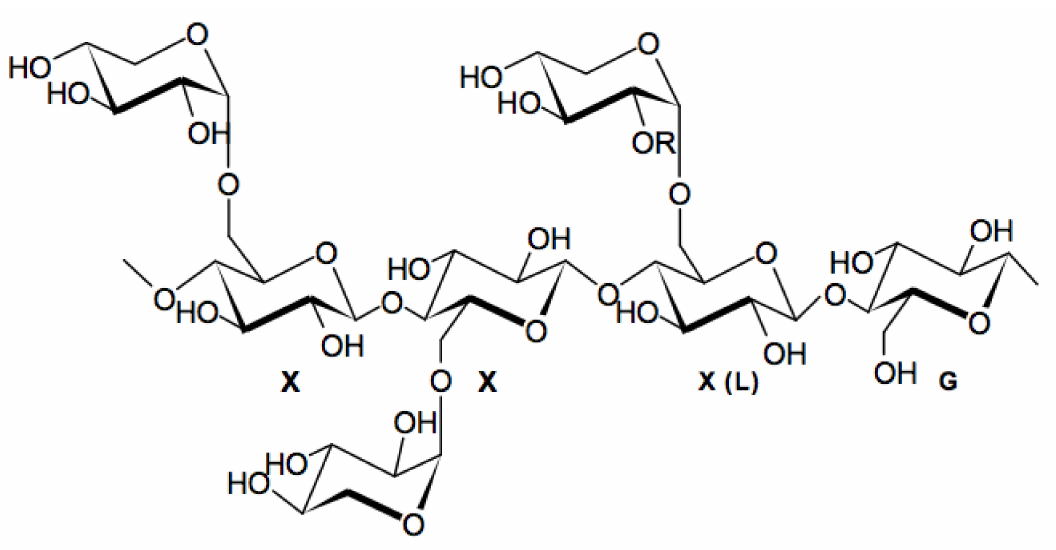
Figure 1. Chemical structure of tamarind seed xyloglucan; motif XXXG or